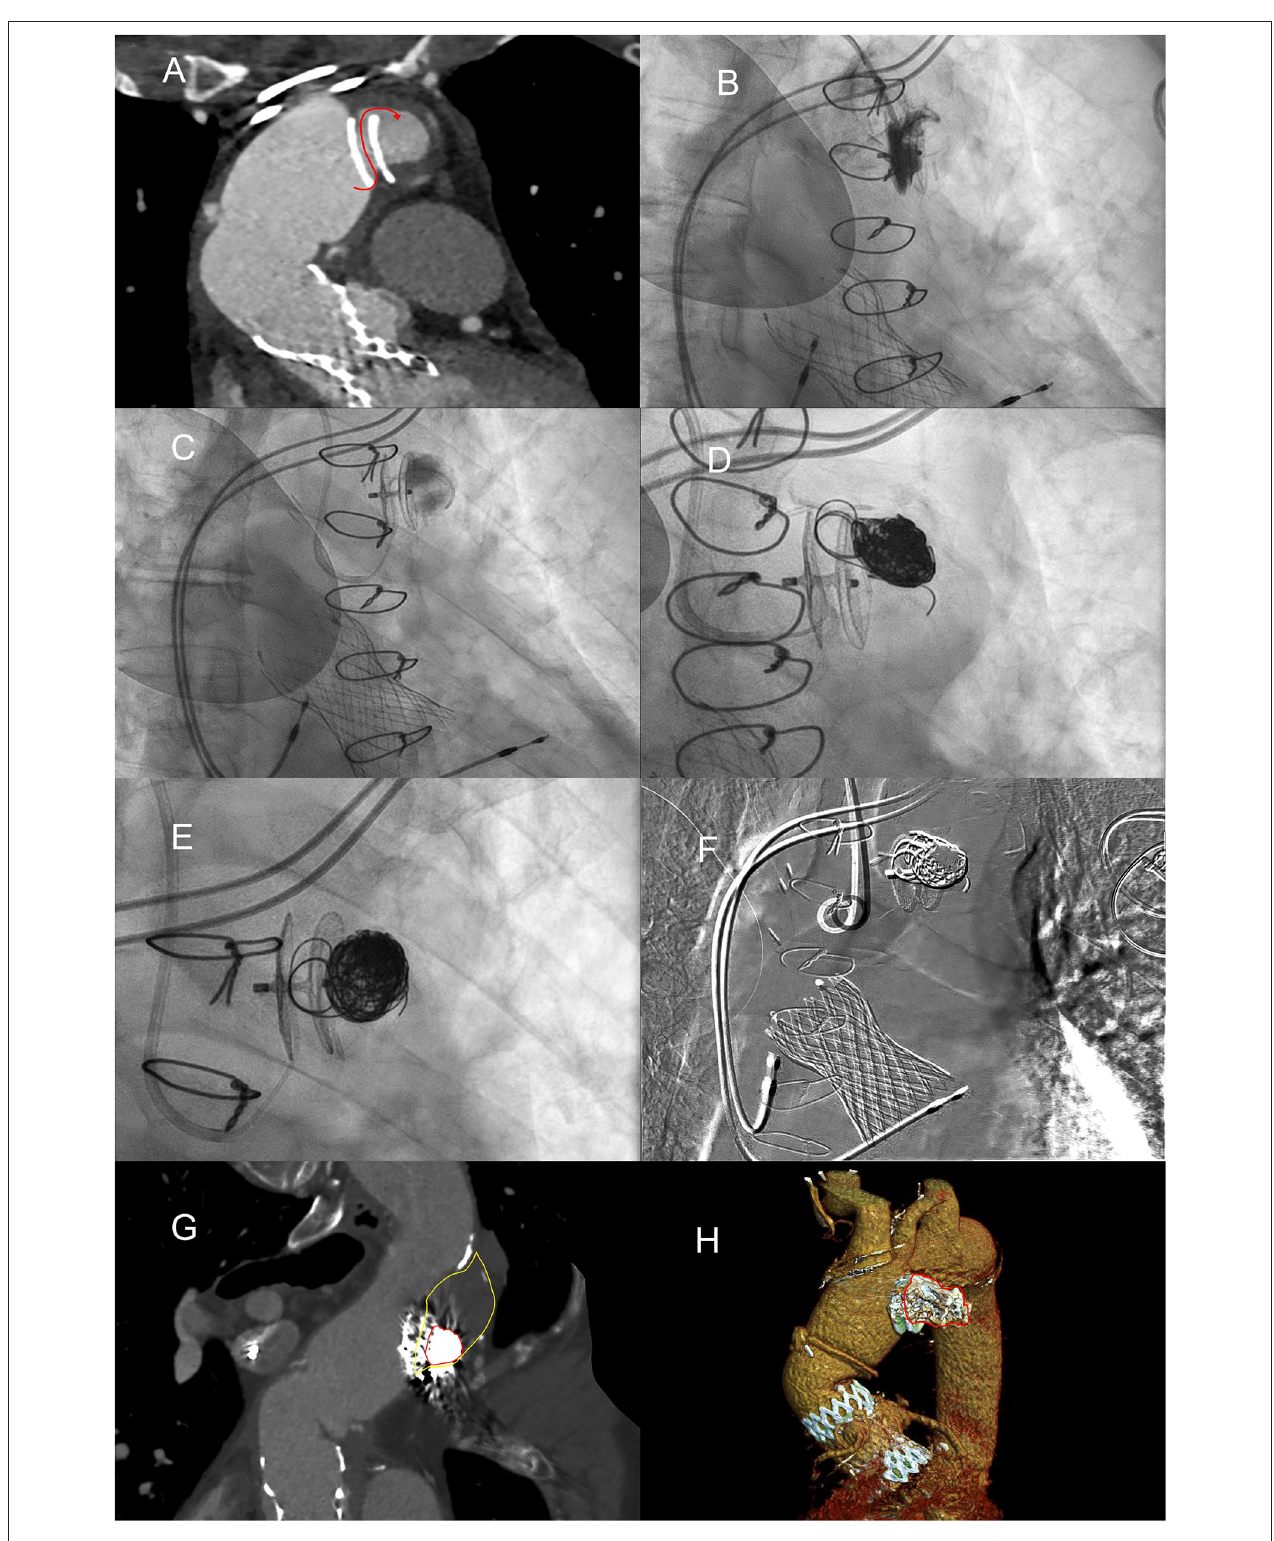
FIGURE 4 | Embolization of the residual pseudoaneurysm, in volumetric expansion. (A) MPR reconstruction demonstrates continuity between the aortic lumen and the pseudoaneurysm lumen with flow direction highlighted by the red curved arrow. (B) Found the direction of blood flow with selective angiography, after